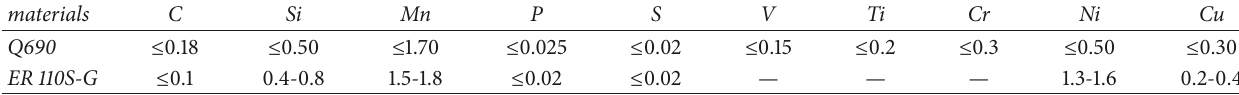
Table 1: The chemical compositions of the tested steel (Q690) and ER 110S-G (wt%).